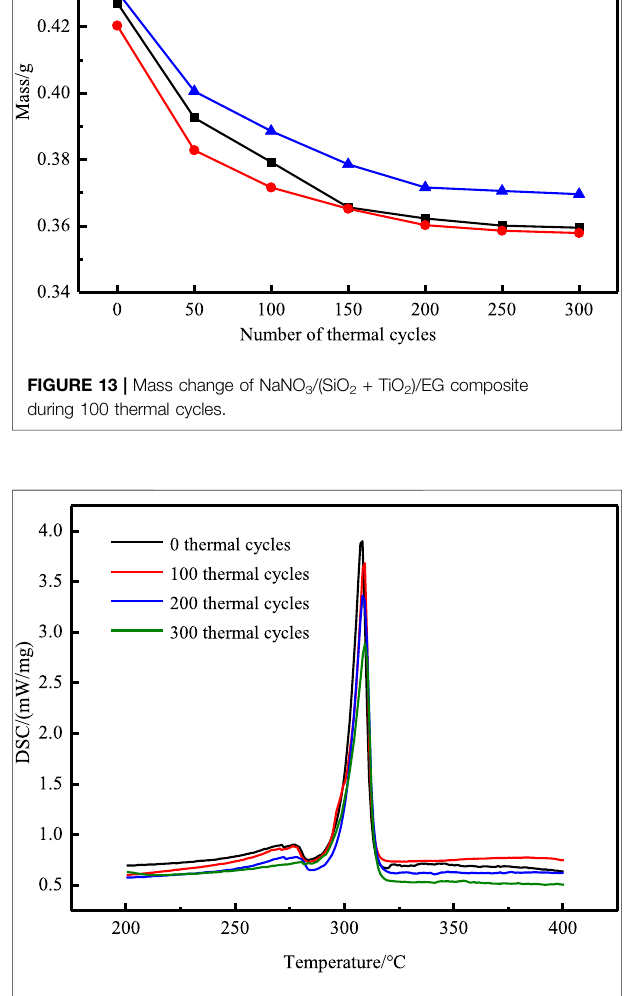
FIGURE 14 | DSC curves of NaNO 3 /(SiO 2 +TiO 2 )/EG composites after 50 and 100 thermal cycles.